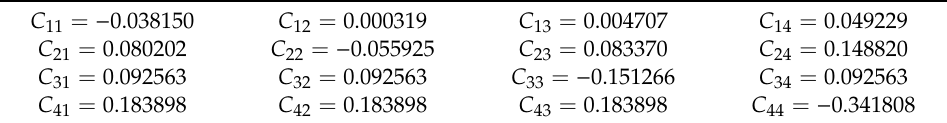
Table 10. The values of the coe ffi cients C ij , i , j =